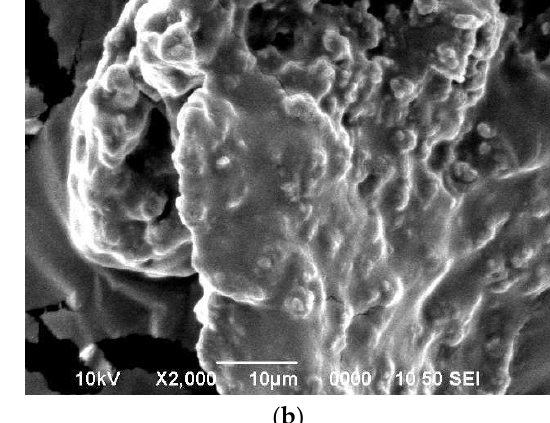
almost 80% of the dry weight, and with arabinose as a minor fraction (Table 3). In spite of the TCA treatment performed for deproteinization, the EPS samples still contained some amount of protein (Data not Table 3. Content of monosaccharides in the produced EPS, % ( w / w ).